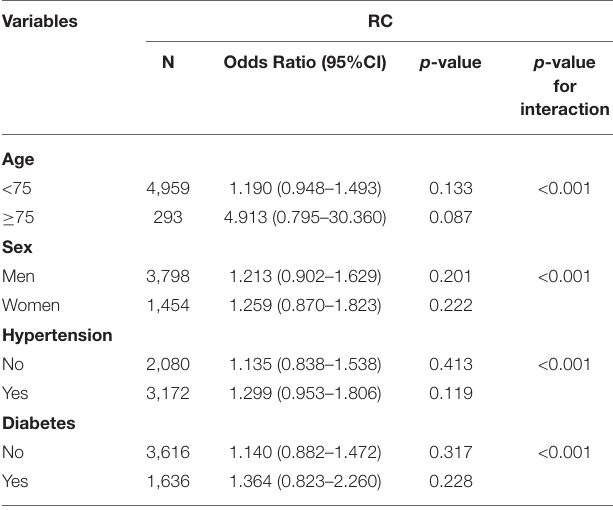
TABLE 4 | The subgroup analyses for the relationship between RC and other risk factors after propensity score matching (PSM).